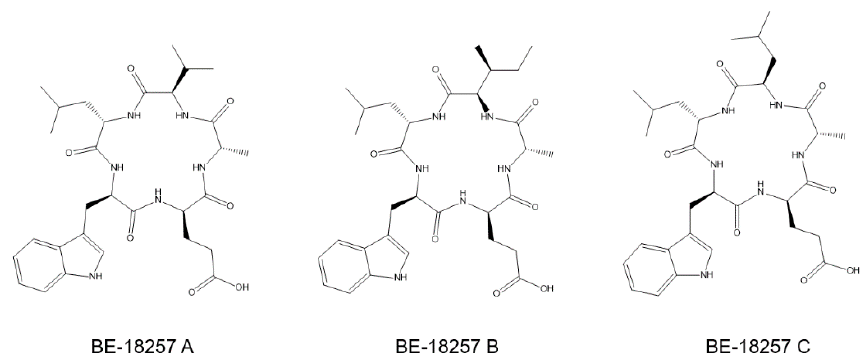
Figure 2. Structures of BE-18257 A–C antibiotics.